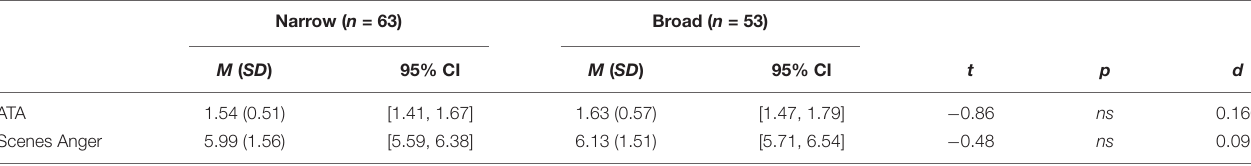
TABLE 5 | Effect of cognitive scope condition on attitudes toward anger and ratings of anger scenes – Study